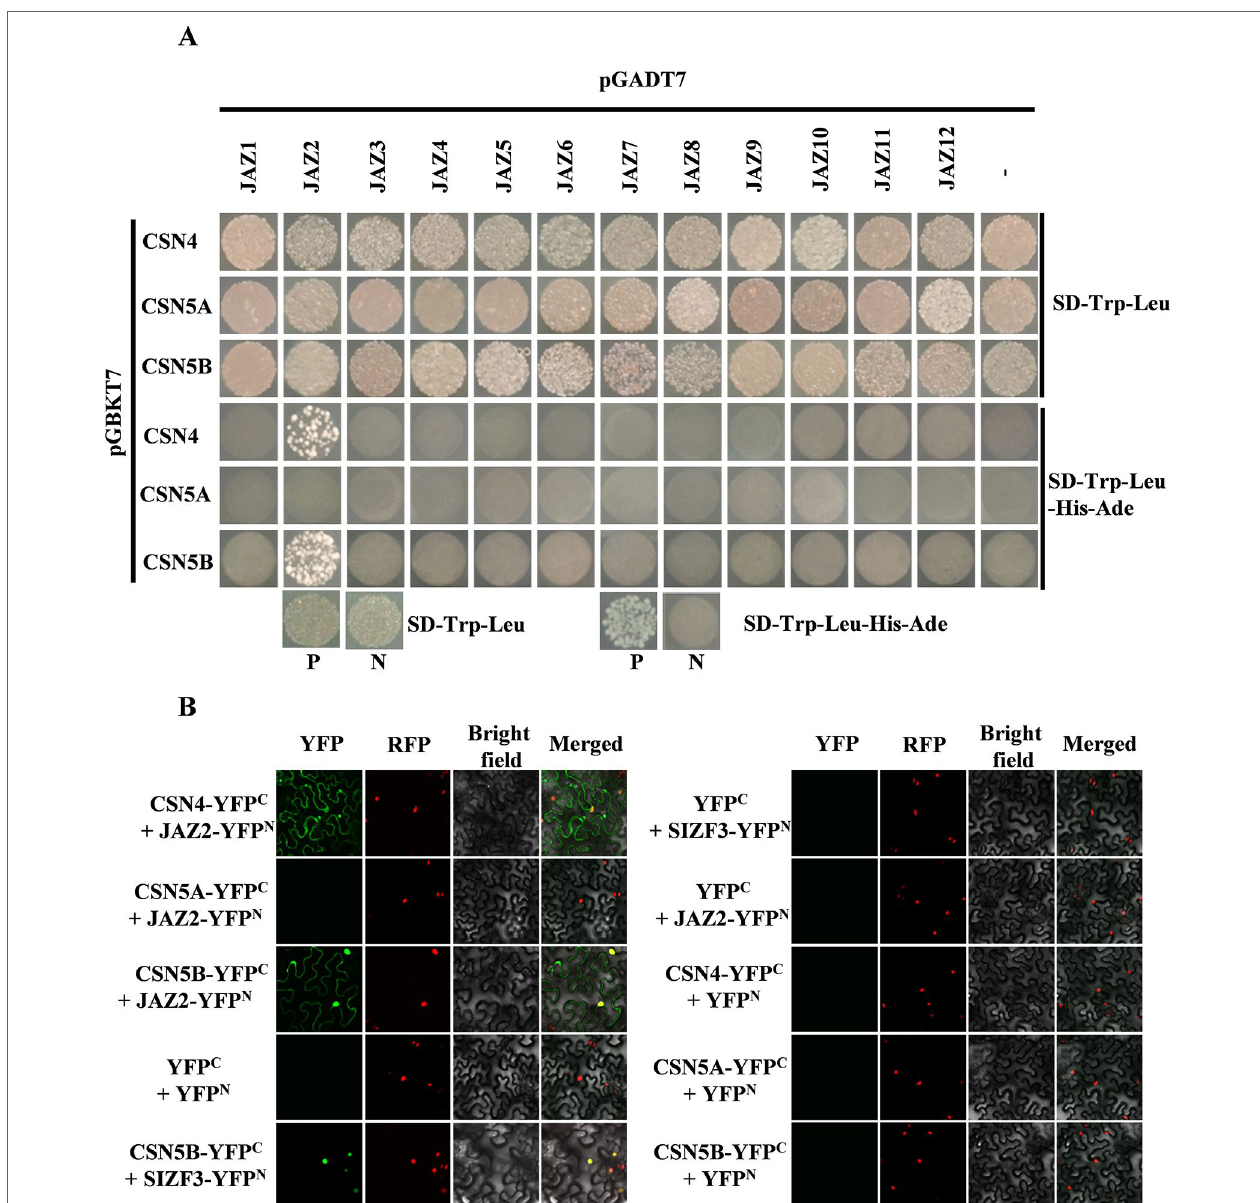
FIGURE 6 | Determination of the interaction between CSN4, CSN5A, CSN5B, and jasmonic acid (JA) co-receptor JAZ2 by yeast two-hybrid (Y2H) (A) and bimolecular fluorescence complementation (BiFC) assays (B) . Three independent experiments were performed with similar results. P, positive control (pGADT7-RecT + pGBKT7-53), N, negative control (pGADT7-RecT + pGBKT7-Lam). Bars = 20